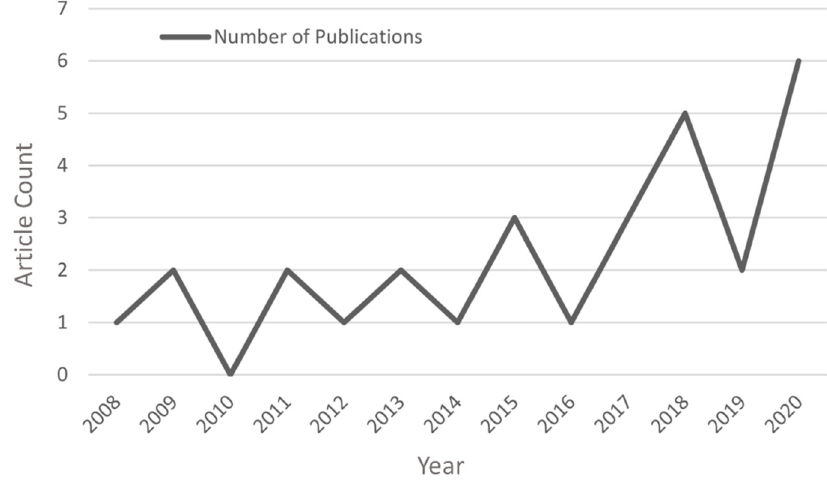
Figure A1. Publications of agent-based modeling (ABM) applications in the food–energy–water systems (FEWS) research domain per year (2020 includes search results up through June of that year). Table A1. Journals in which reviewed agent-based models were published.